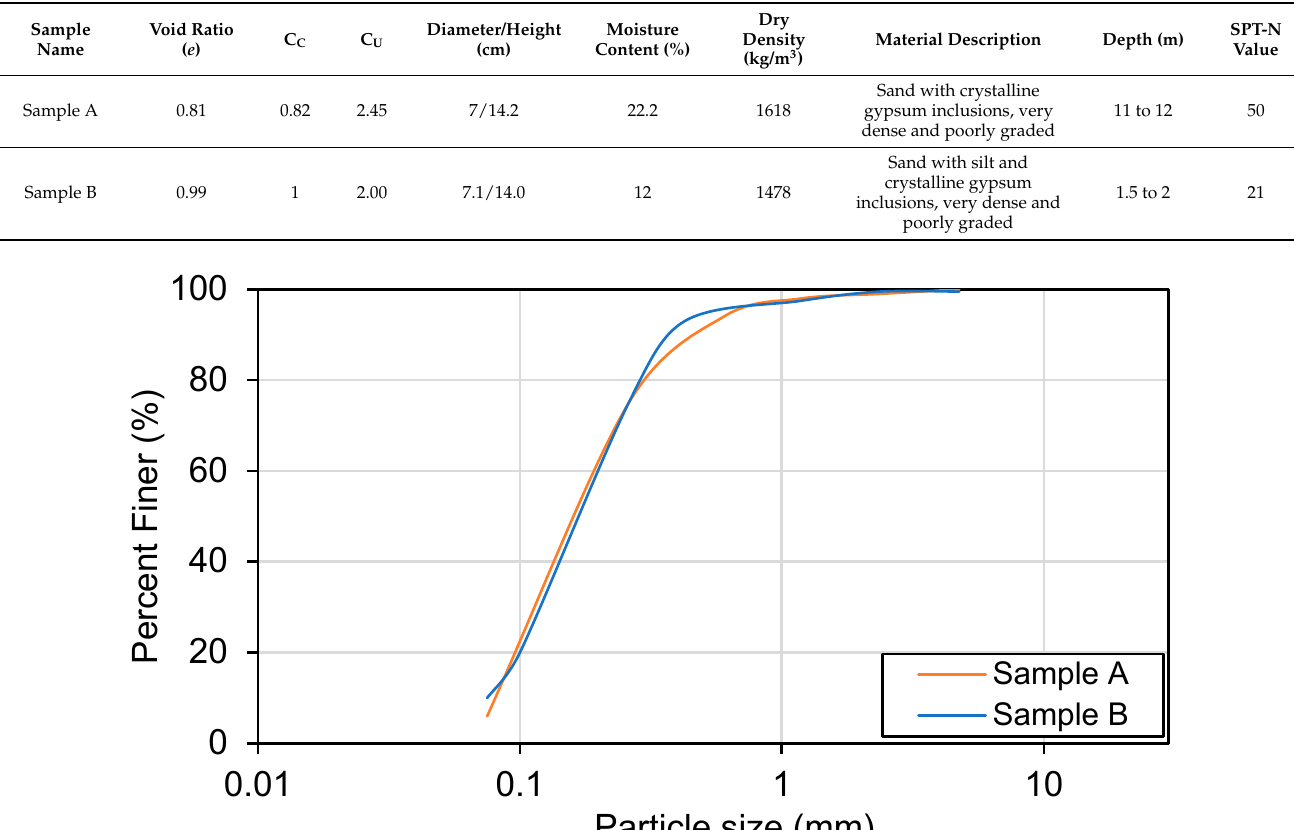
Table 3. Physical properties of the tested specimens and standard penetration test (SPT) values.